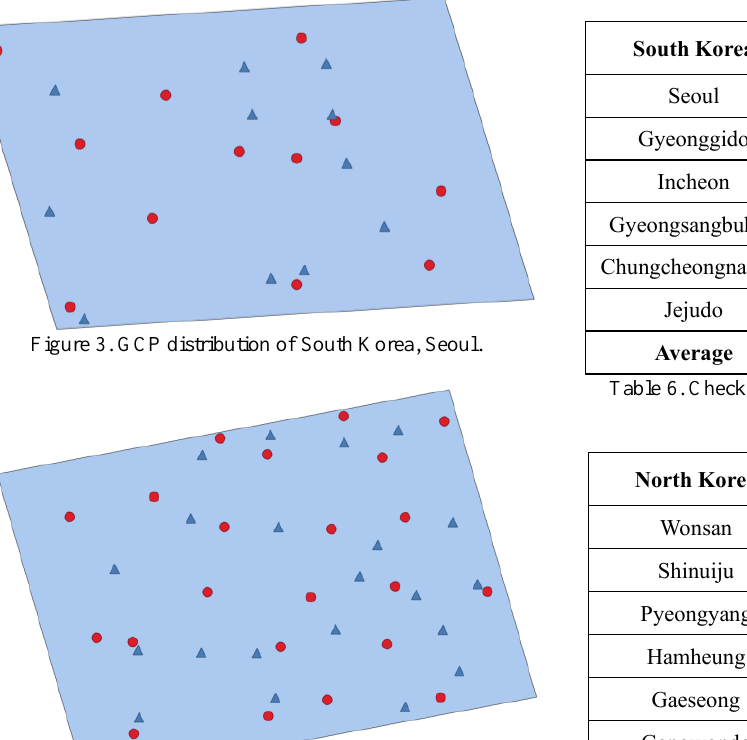
Table 5. Model point geolocation accuracy of precise sensor model (North Korea).